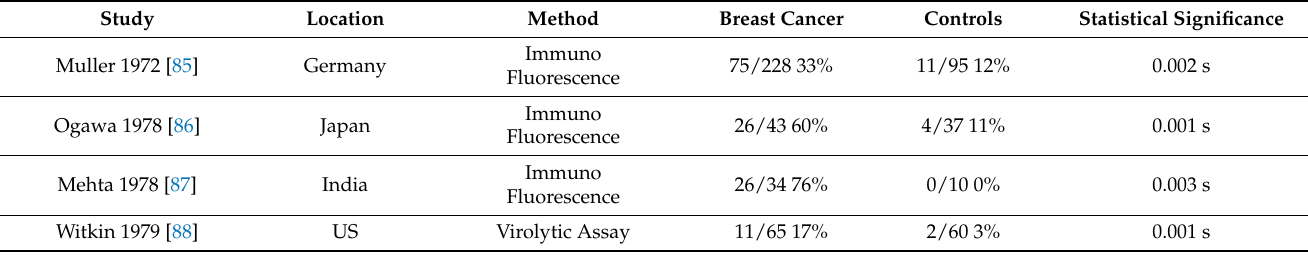
Table 2. Mouse mammary tumour virus breast cancer